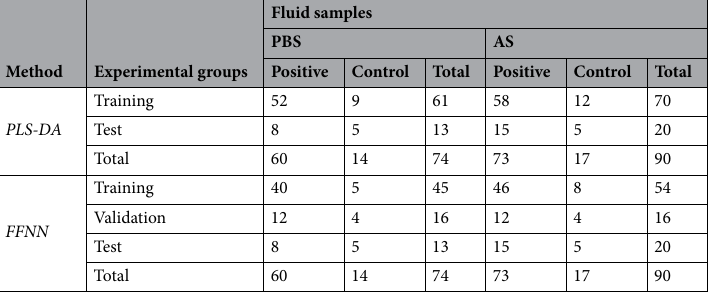
Table 3. Number of droplets analysed using the PLS-DA and FFNN